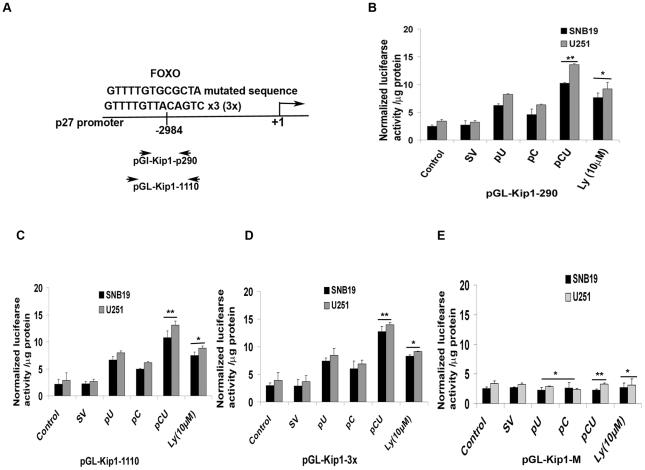
Regulation of p27Kip1 activity in cathepsin B and uPAR-depleted glioma cells occurs through FOXO3a transcription factor.
A. Schematic representation of the p27Kip1 promoter with the normal and mutant versions of the putative FOXO binding site and the regions used for PCR amplification. B–E. SNB19 and U251 cells were initially transfected with SV, pU, pC or pCU, and treated with Ly294002 (Ly 10 µM) separately. 24 hrs after the treatments, a second transfection with the luciferase constructs was performed as described in Materials and Methods. The luciferase expression was quantified using Promega's luciferase assay kit with a Turner Luminometer and is represented graphically. The graphs show luciferase expression when pGL-Kip1-290 (B), pGL-Kip1-1110 (C), pGL-Kip1-3x (D), and pGL-Kip1-M luciferase constructs were used. Assessment for luciferase expression was performed at least in triplicate (*p<0.05, **p<0.01).